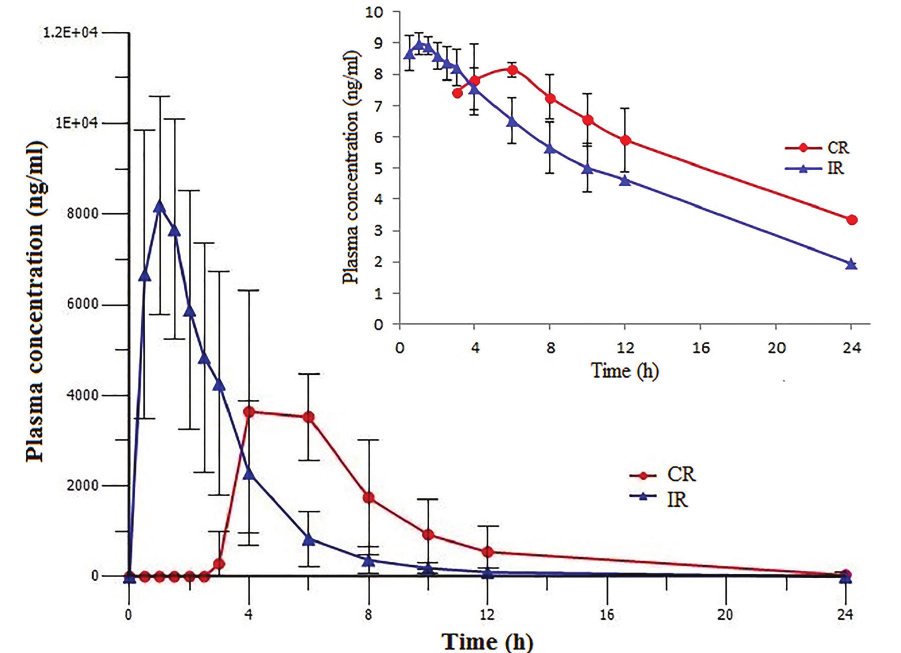
FIGURE 3 – Mean ± SD plasma concentration-time curves of ketoprofen following the administration of IR-tablets and CR-tablets (n=6). Inset: semi-logarithmic presentation. IR-tablets – mini-tablets with immediate release; CR-tablets – compression-coated tablets for colonic